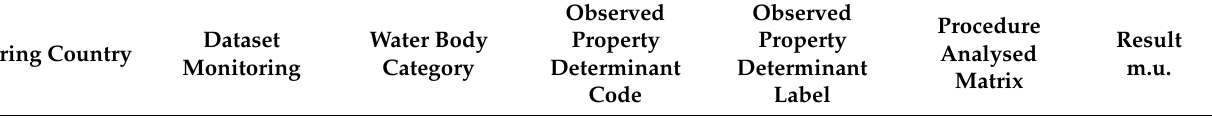
Table 1. Technical data on analysed